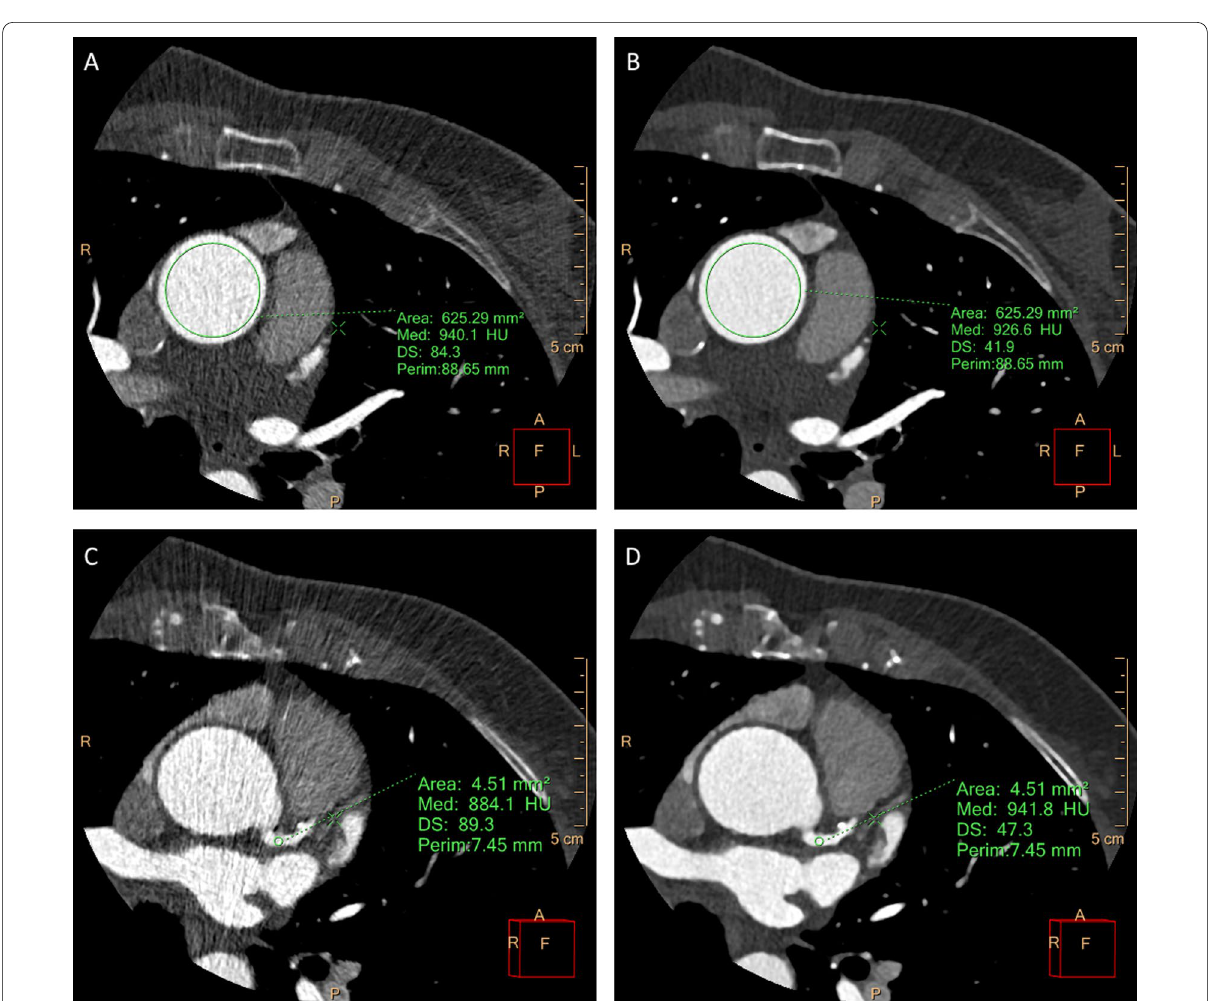
Fig. 2 Evaluation of noise and HU of the same patient’s examination dataset reconstructed with the two different iterative algorithms, model-based (MBIR) and hybrid-iterative (IR). CCTA was acquired with an 80-kV protocol, with a low radiation dose exposure (DLP 98.5 mGy with a CADARAD score of 0. a – c Axial images reconstructed with IR with circular ROI placed in the proximal ascending aorta and common trunk. b – d Axial images reconstructed with MBIR with circular ROI placed in the same position as figures A and C. Because of the use of the model-based iterative reconstruction algorithm (MBIR), we obtained an image noise reduction of 50% compared to IR reconstruction as reported in the images: IR standard deviation (SD) in aorta 84 and common trunk 89; MBIR SD: aorta 42 and common trunk